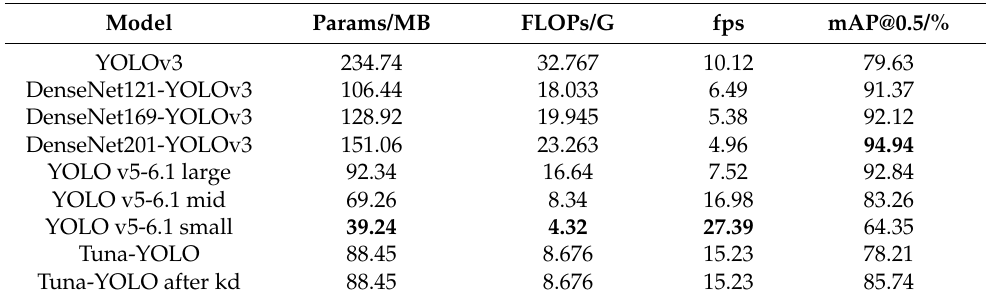
Table 6. Comparison of model performance.